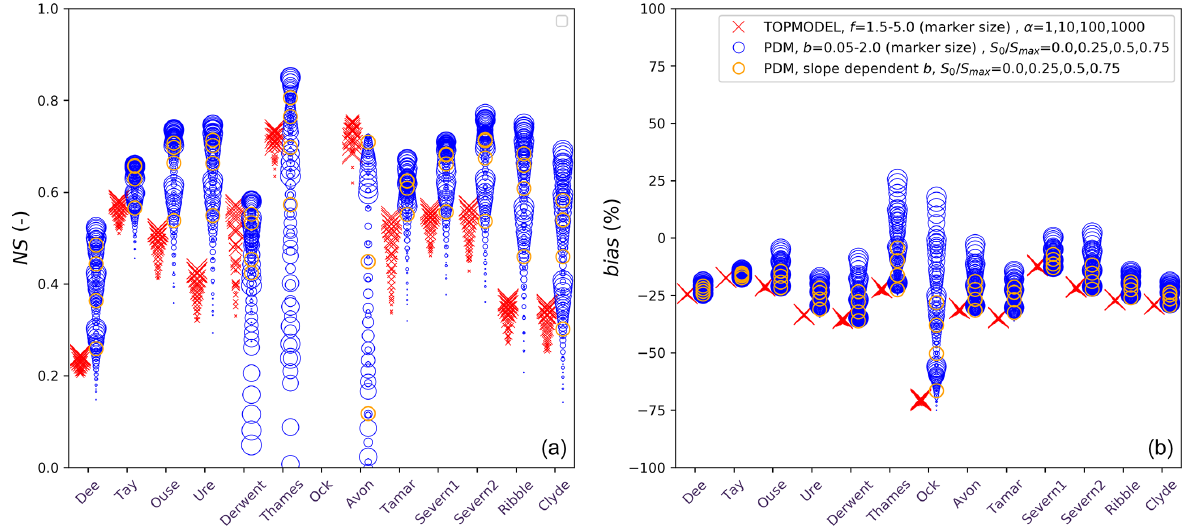
Figure 4. River flow performance metrics for catchment tests detailed in Sect. 2.2.2 (red crosses for TOPMODEL tests, blue circles for PDM tests with fixed parameters and orange circles for PDM tests with slope-dependent b ). (a) NS efficiency. (b) Mean bias. The x axis represents the 13 selected catchments (Fig. 1). The marker size represents the parameter corresponding to a given tests (and larger crosses for larger f values in the TOPMODEL tests and larger circles for larger b values in the PDM tests). No distinction is shown here indicating the S 0 /S max or α parameters. Only results from those tests using the VG approach for soil formulation are shown. Tests at the Ock catchment are not visible since they obtained negative NS.